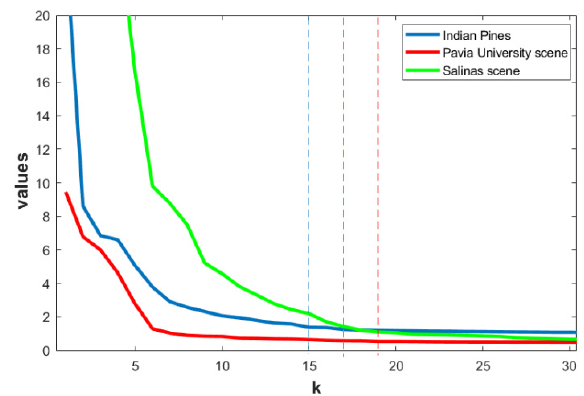
Figure 4. Results of the eigenvalue curve of three hyperspectral datasets through choosing rule.